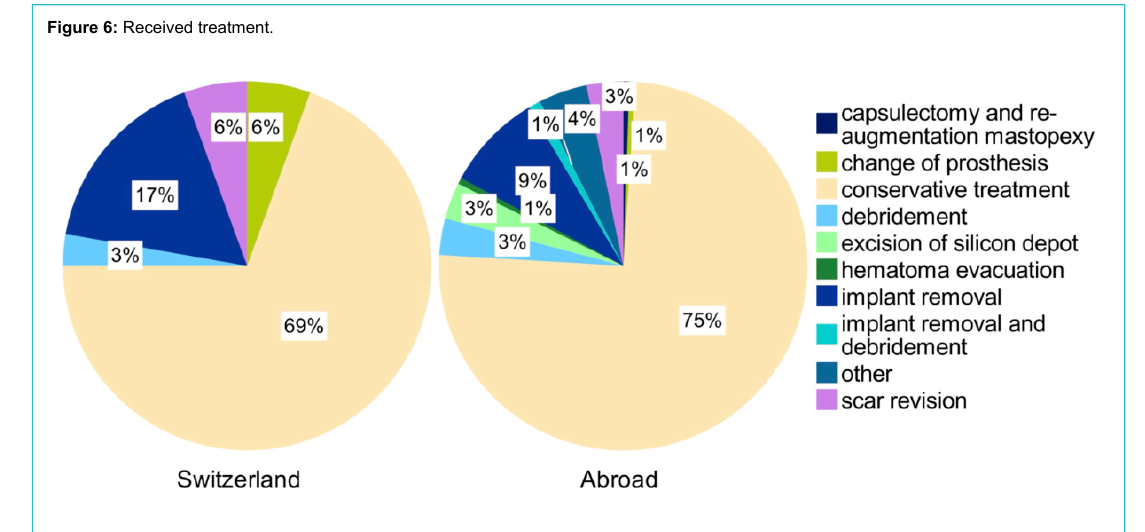
Figure 6: Received treatment.